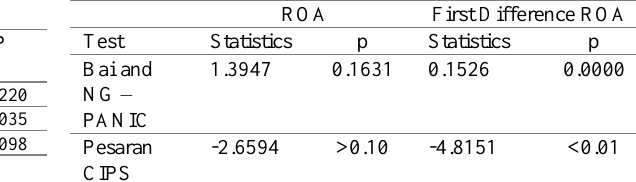
Table 9. Unit root test results of Model